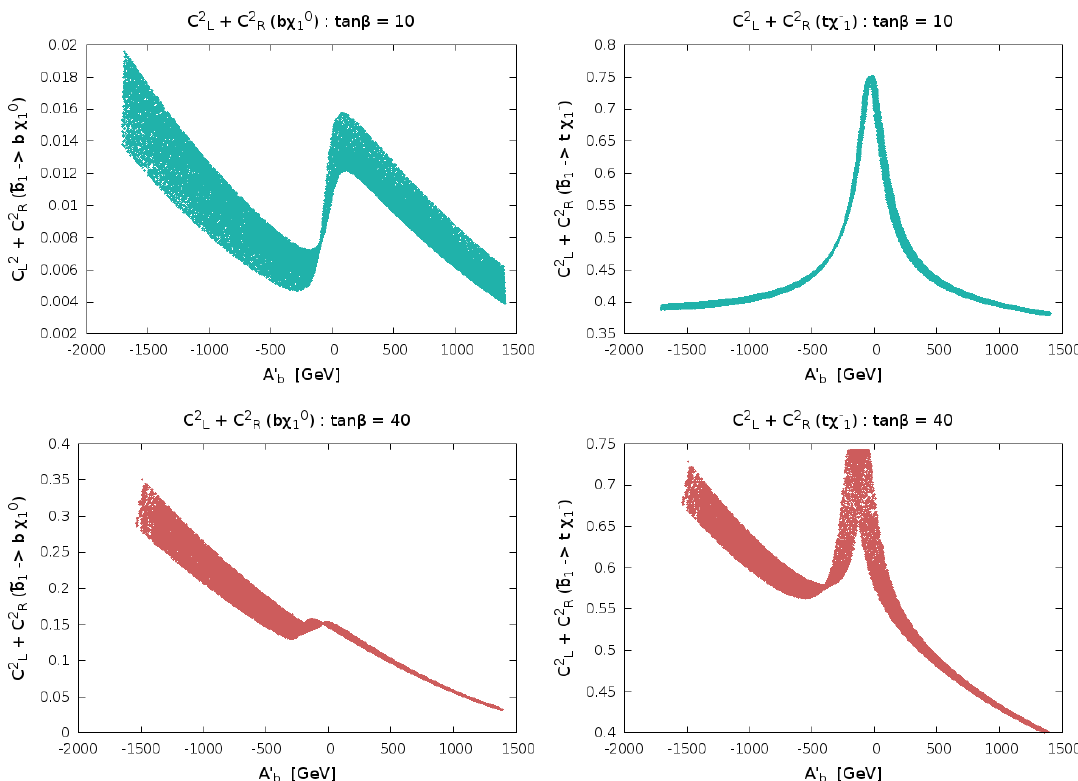
Figure 3 . Variation of the e(cid:11)ective interaction strengths ( C 2 (left) and ~ b 1 t(cid:31) (cid:0) (right) as functions of A 0 1 ! scenario with a higgsino-like neutralino LSP. The (cid:12)xed input range of ‘ (cid:22) ’ is 100 GeV Other (cid:12)xed parameters used are as follows: M 1 = 500 GeV, M 2 = 1 : 1 TeV, (cid:22) 0 = 0, A b = 0 while m ~ = m ~ =1.2 b L b R